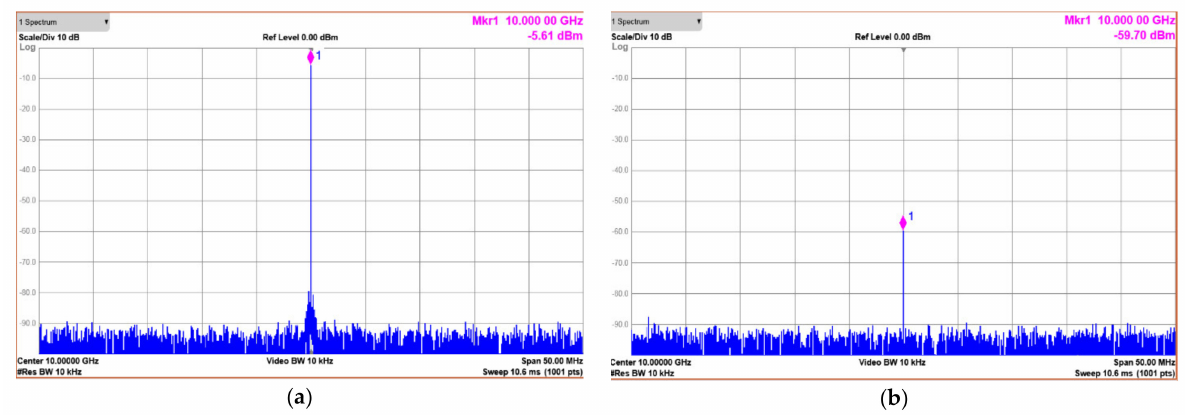
Figure 17. ( a ) The spectrum measurement for ON state with 10 KHz BW and 50 MHz frequency span range; ( b ) the spectrum measurement for OFF state with 10 KHz BW and 50 MHz frequency span